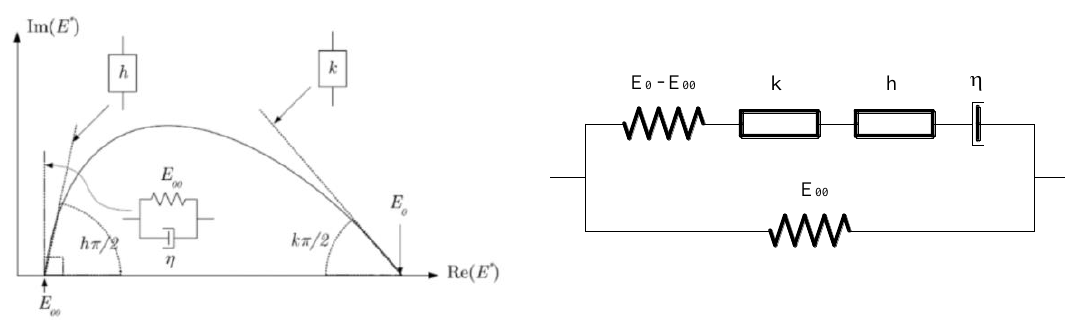
Figure 23. 2S2P1D model parameters in Cole-Cole model.